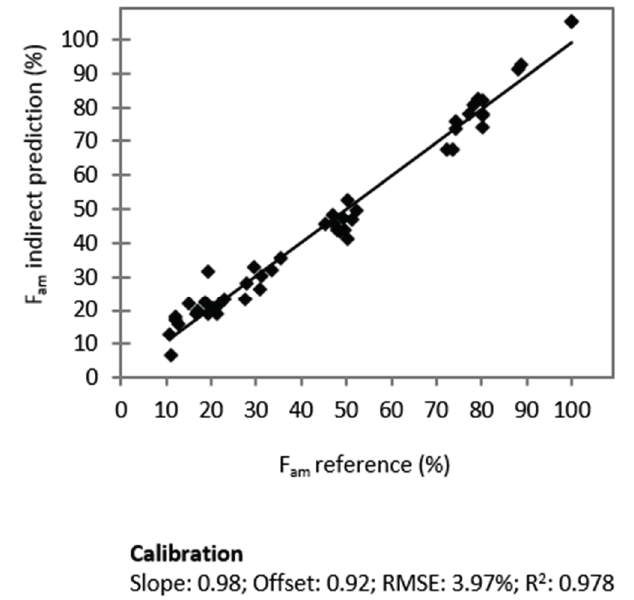
Figure 6. Correlation of the indirectly predicted amorphous fraction vs. the reference values. For comparison, F am was also predicted based on the relative area (A) under the Bragg peaks in the diffractograms. Correlation of the true F am values of the calibration samples vs. the predicted A values and linear regression resulted in a calibration function. The predicted values for F am using the calibration function are plotted vs. the reference fractions in Figure 7. two